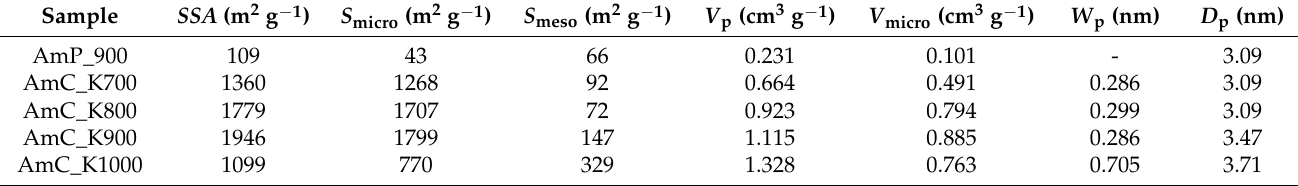
Table 1. Surface textural properties of the directly carbonized sample, and the KOH-activated Amala seed carbons obtained by the carbonizations at different temperatures (700–1000 ◦ C) 1 .